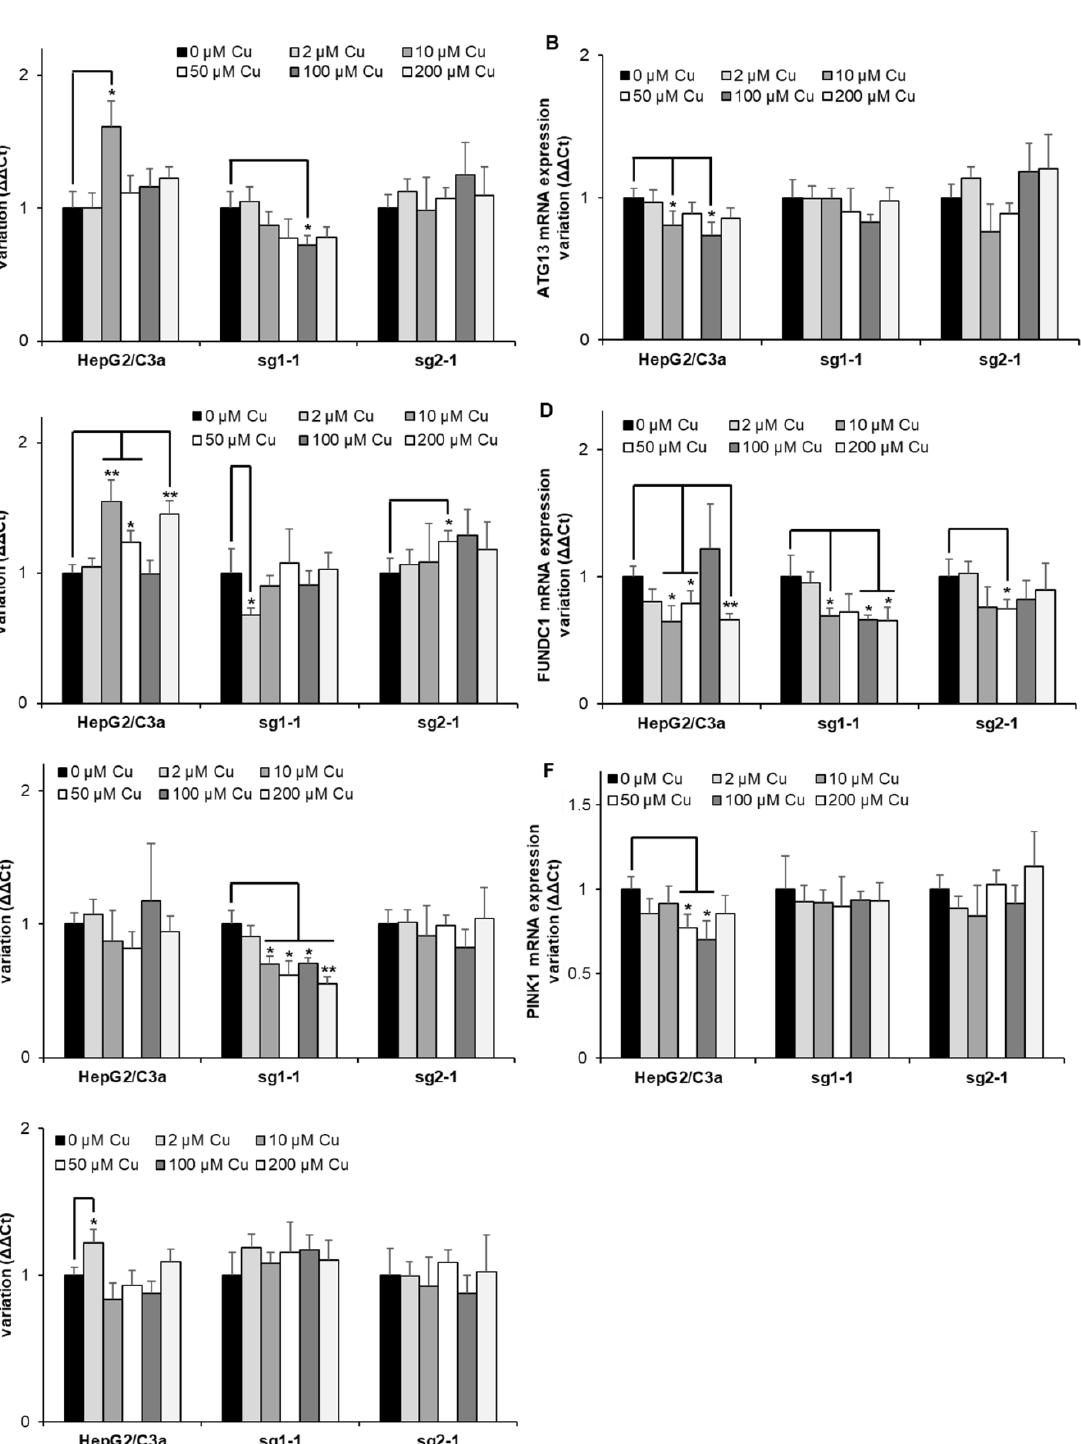
Figure 7. Autophagy response in cell lines with or without ATP7B. HepG2/C3a, sg1-1, and sg2-1 cells were exposed to increasing concentrations of Cu. ATG7 ( A ), ATG13 ( B ), BNIP3L ( C ), FUNDC1 ( D ), Get3 ( E ), PINK1 ( F ), and Drp1 ( G ) mRNA variation expression were determined following 6 h of exposure to Cu. Results are expressed as the relative change in expression compared to the control. All the data are expressed as means +/ − standard error of the mean of at least three independent experiments. * stands for data statistically different from the control unexposed to Cu with p < 0.05, and ** stands for data statistically different from the control unexposed to Cu with p < 0.01.